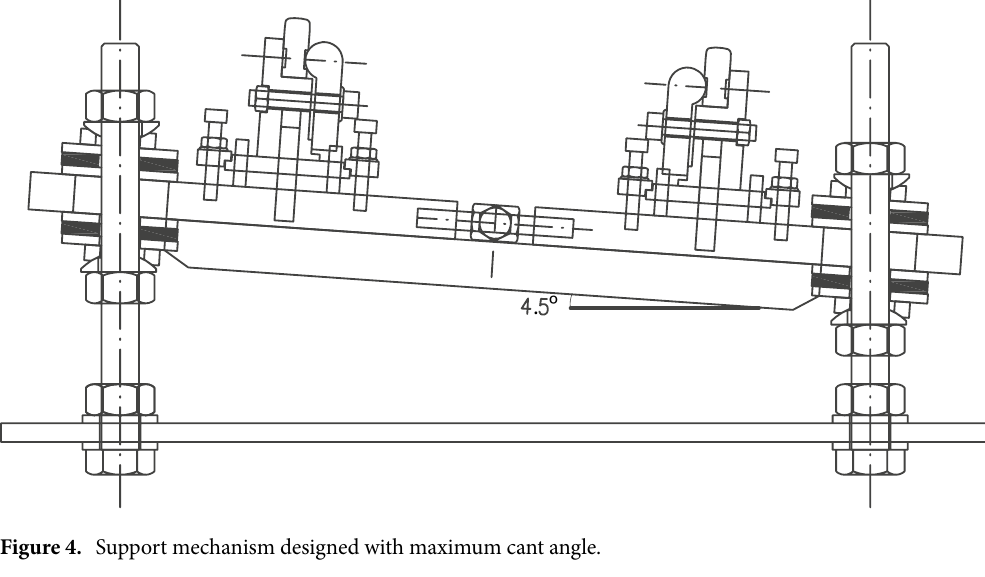
Figure 4. Support mechanism designed with maximum cant angle.